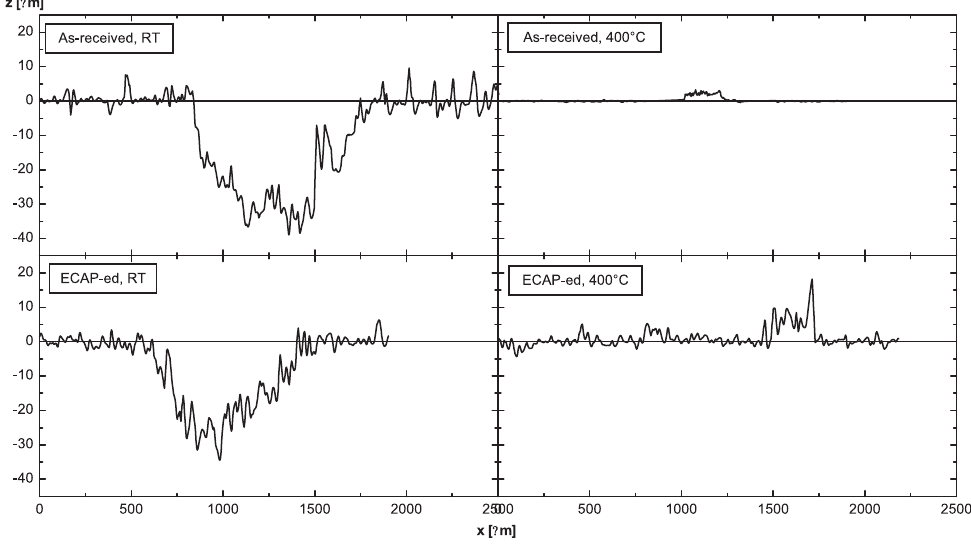
Fig. 6: Typical profiles of wear tracks in Glidcop based materials formed by testing at room temperature and 673 K.